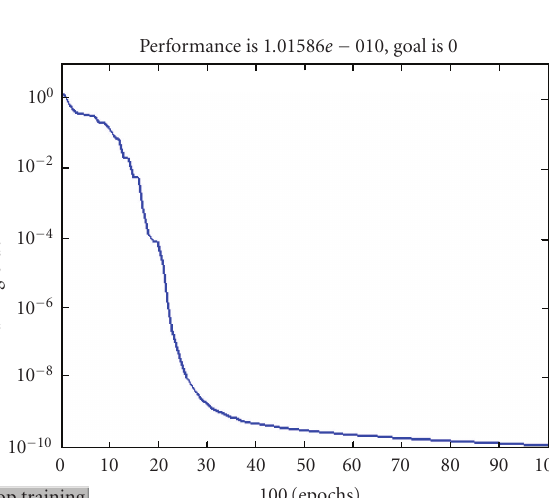
Figure 12: Pattern classifier.